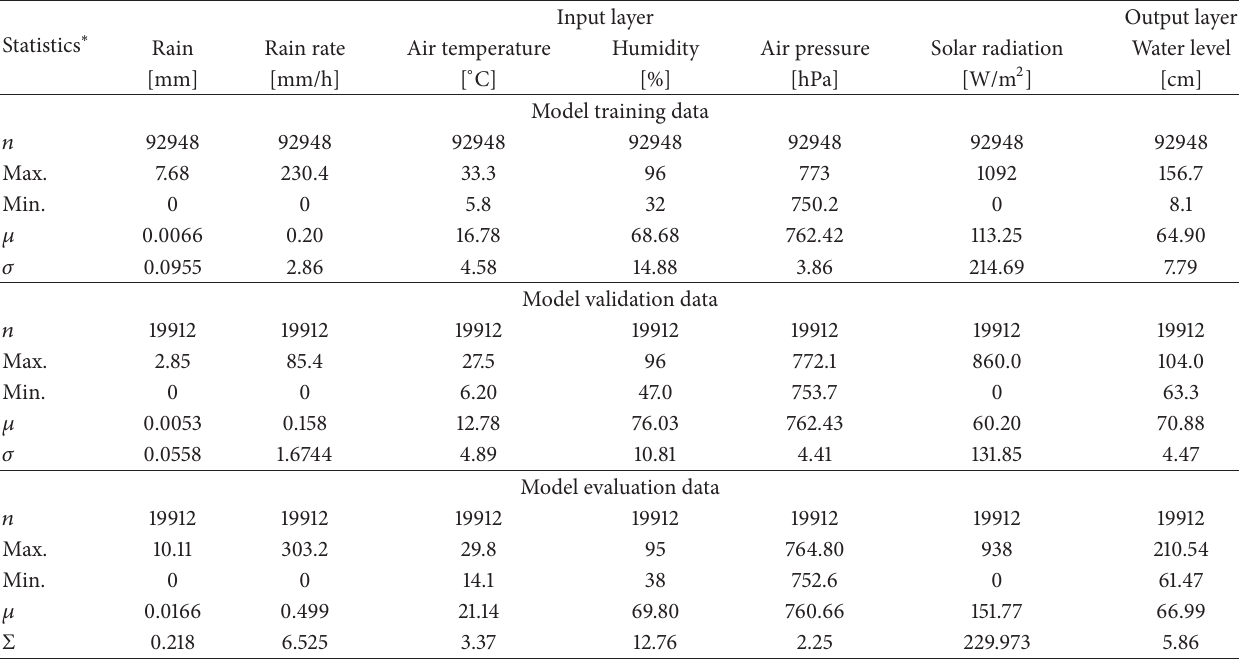
Figure 13: Evaluation classes of the target water level data. Table 2: Statistics of data used for training and evaluation of the ANN